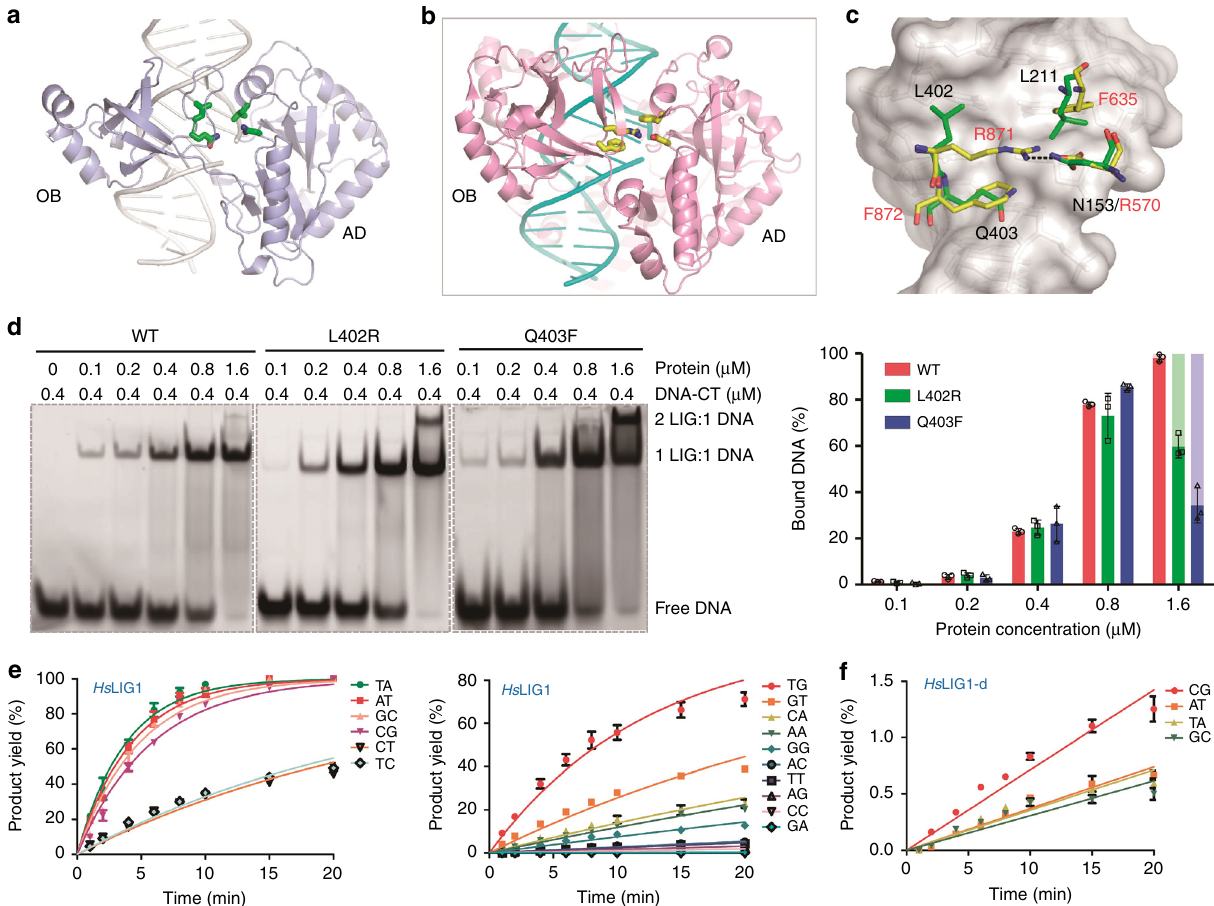
Fig. 6 Unique ligase residues in proximity of the nick in the substrate DNA of Asfv LIG. a , b Cartoon representation showing the DNA-binding surface formed by the AD and OB domains of Asfv LIG and Hs LIG1, respectively. c Superposition of the ligase residues in proximity of the nick in the substrate DNA. In ( a – c ), all the ligase residues are shown as sticks. Identical colors are utilized for the N-atoms (blue) and O-atoms (red) in both structures, but the C- atoms are colored in yellow and green in Asfv LIG and Hs LIG1, respectively. d Comparison of the in vitro DNA-CT binding by WT Asfv LIG, and L402R and Q403F mutants. In the right panel, WT Asfv LIG, and L402R and Q403F mutants are colored in red, green, and blue, respectively. The complexes with protein:DNA molecular ratio of 2:1 are colored in light-green or light-blue. All data points from three independent experiments are shown with the median expressed as bars. The standard deviation (±SD) values are indicated by error bars. Uncropped gels are shown in Supplementary Fig. 13. e In vitro DNA ligation catalyzed by WT Hs LIG1. f In vitro DNA ligation catalyzed by Hs LIG1-d mutant. Hs LIG1-d and Hs LIG1-q stand for R871L/F872Q double mutant and D570N/F635L/R871L/F872Q quadruple mutant, respectively. The data represent the mean of three independent experiments, and the standard deviation (±SD) values are indicated by error